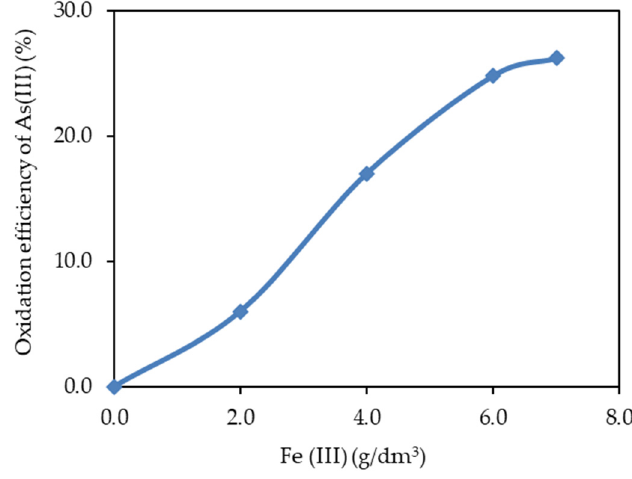
Figure 1. As (III) oxidation efficiency as a function of Fe (III) ion concentration with no oxygen introduced into the system.